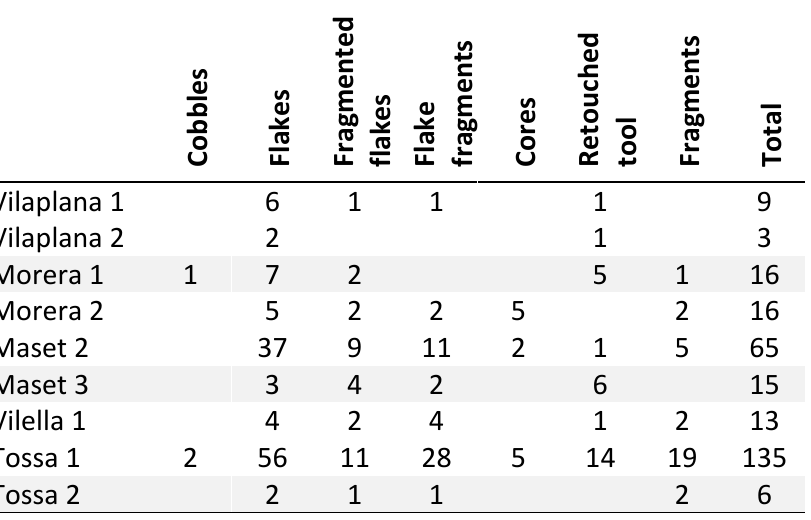
Table 3. Chert type distribution according to the structural categories of the knapping sequence.